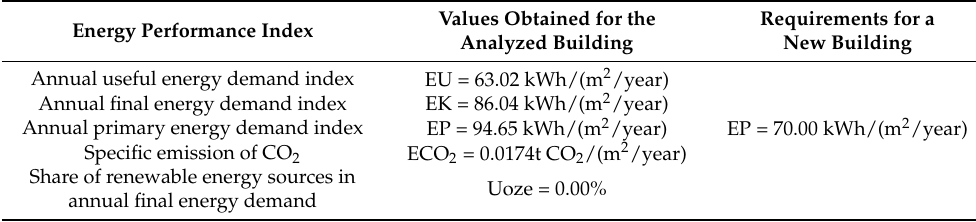
Table 3. Energy performance of a building using non-renewable heat sources (natural gas).